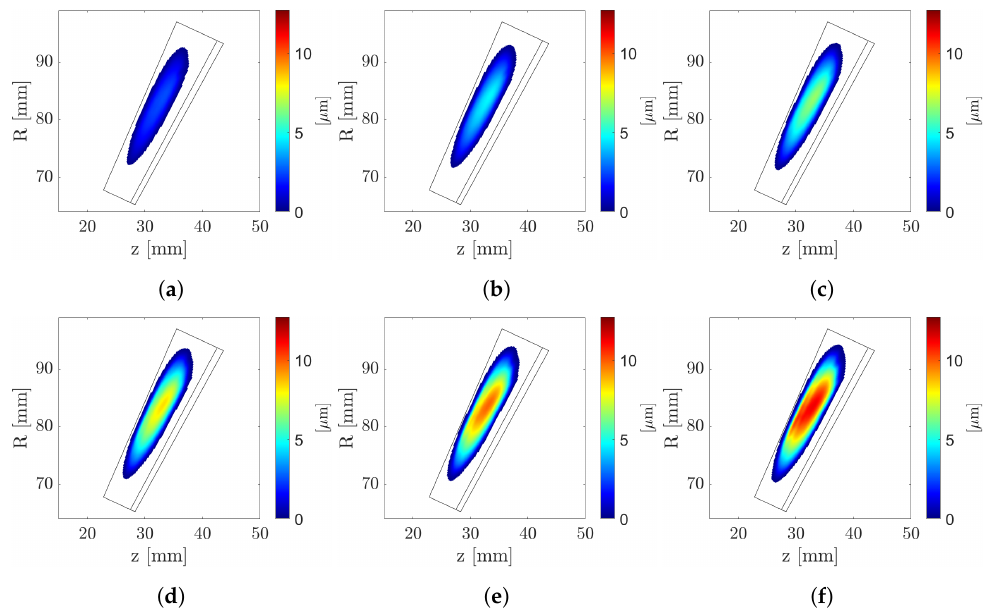
Figure 15. Evolution of the gear (cumulative) wear pattern with a geometry update every 5